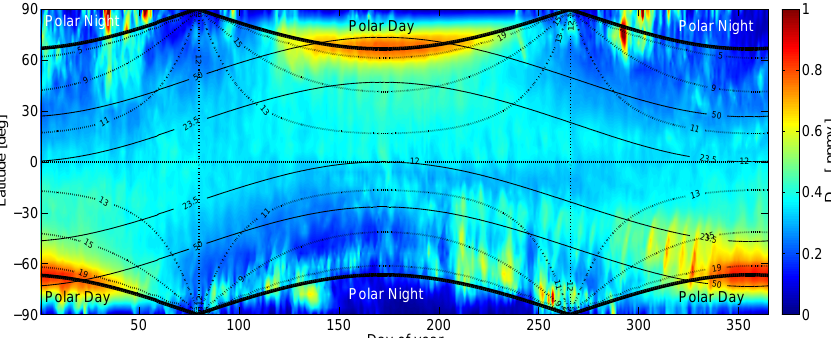
Figure 6. Seasonal changes in the strength of the daily ozone cycle at 5hPa. The figure shows zonal-mean D O and latitude derived from WACCM. The overlaid solid contours refer to the solar zenith angle at noon. Thick solid lines depict the borders of the polar day and polar night. Dashed contours show the sunshine duration given in